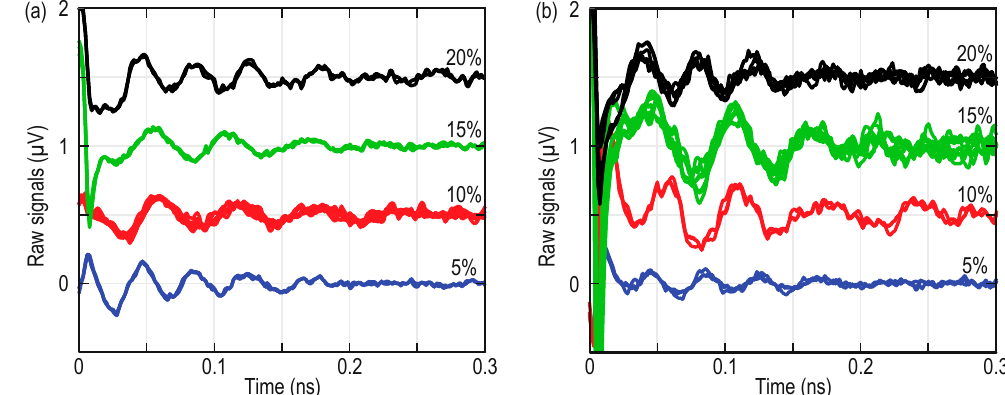
Figure 2. Acoustic part of the signals obtained in the (Bi 1 − x Pr x )(Fe 0.95 Mn 0.05 )O 3 films deposited on Si after the subtraction of the low-frequency contribution of non-acoustic origins to reflectivity: ( a ) for time-domain Brillouin scattering (TDBS) measurements at normal incidence (0°) and ( b ) for those at oblique incidence (52°). Each percentage number denotes the Pr substitution concentration (x) associated with all curves with the same ordinate, and each curve at a given substitution concentration corresponds to a different probed location on the sample.